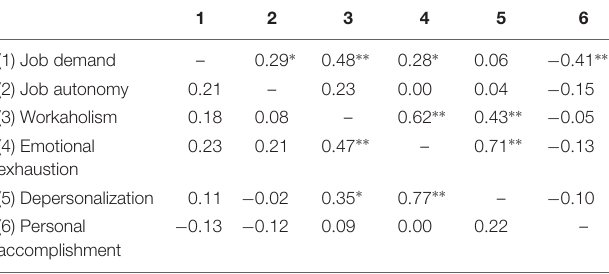
TABLE 3 | Correlation table – natural resources, mining and construction industry.